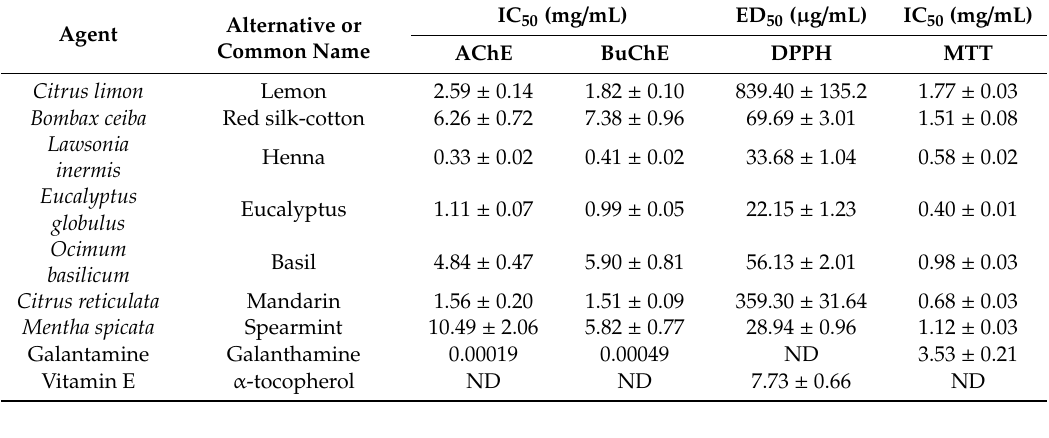
Table 1. AChE and BuChE inhibitory capacity, DPPH radical scavenging, and cell viability assessment (MTT assay) of plant extracts.